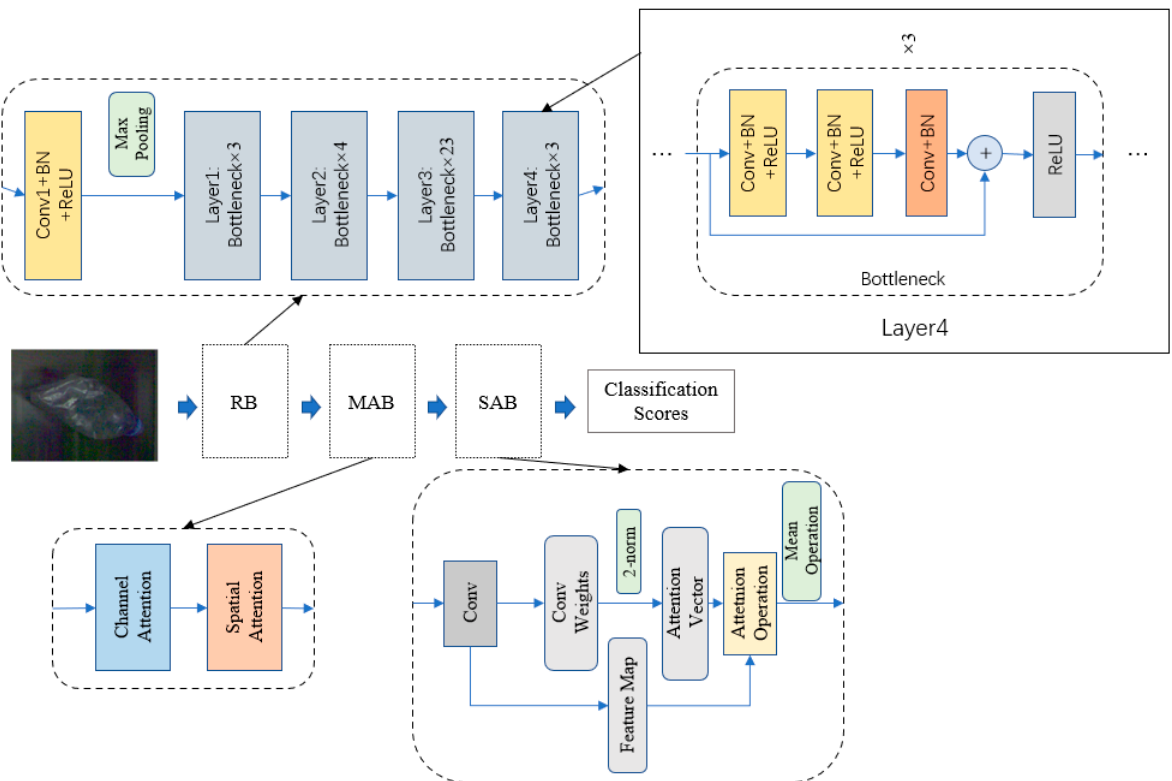
Figure 1. Network architecture of SAF. The residual learning block (RB) is pretrained to learn more context features. The mixed attention block (MAB) can extract salient category information via the simultaneous use of channel attention and spatial attention. The self-attention block (SAB) constructs a classifier with attention to improve performance.